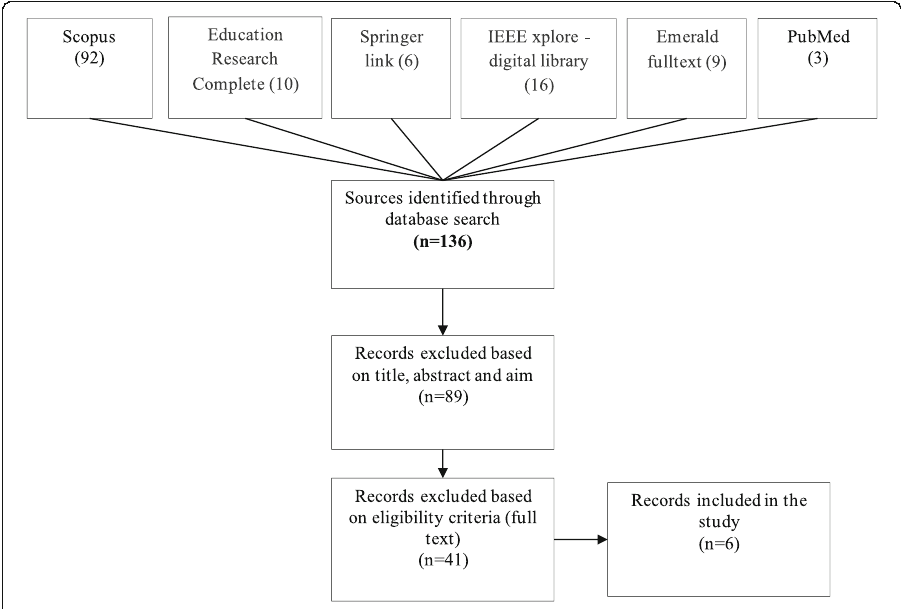
Fig. 1 Process flow used in identifying relevant academic